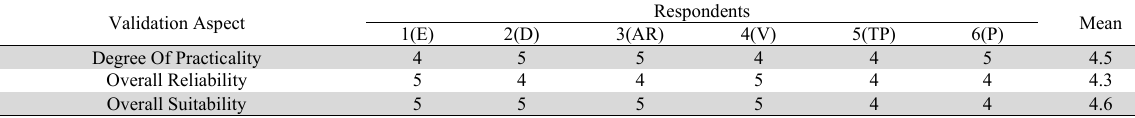
Outcomes of Validation of the Decision Tree